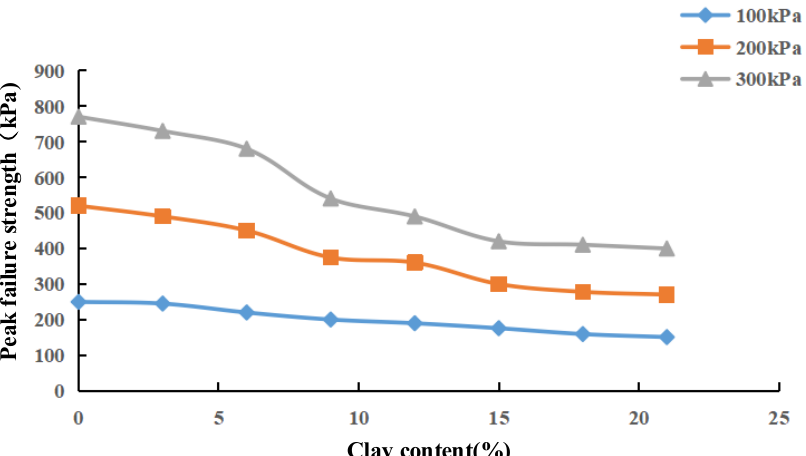
Figure 7. Peak breaking point strength curve with different viscous particle contents.